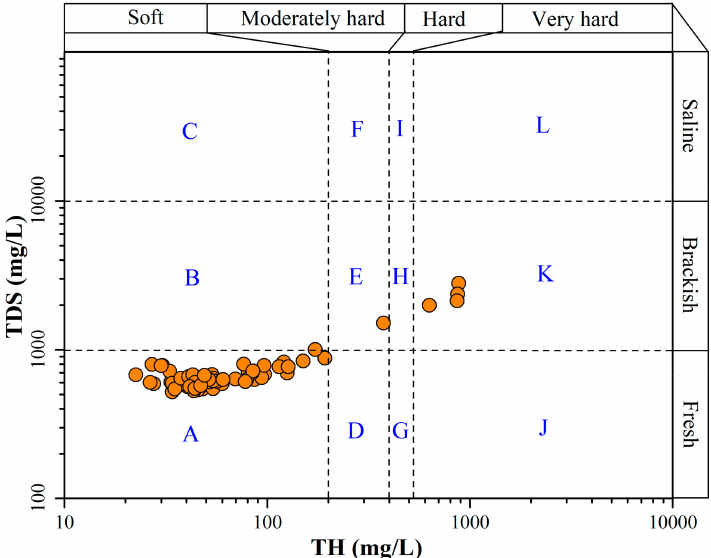
Figure 3. Scatter plots of TH versus TDS demonstrating groundwater